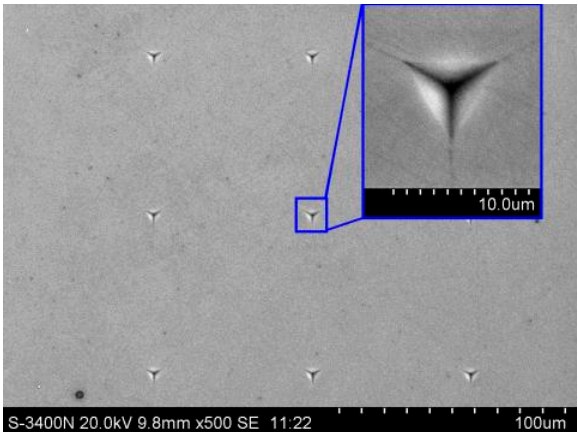
Figure 3. Surface topography of nanoindentation. Table 2. Hardness and elastic modulus of Single crystal 6H-SiC substrates by quasi-static indentation.